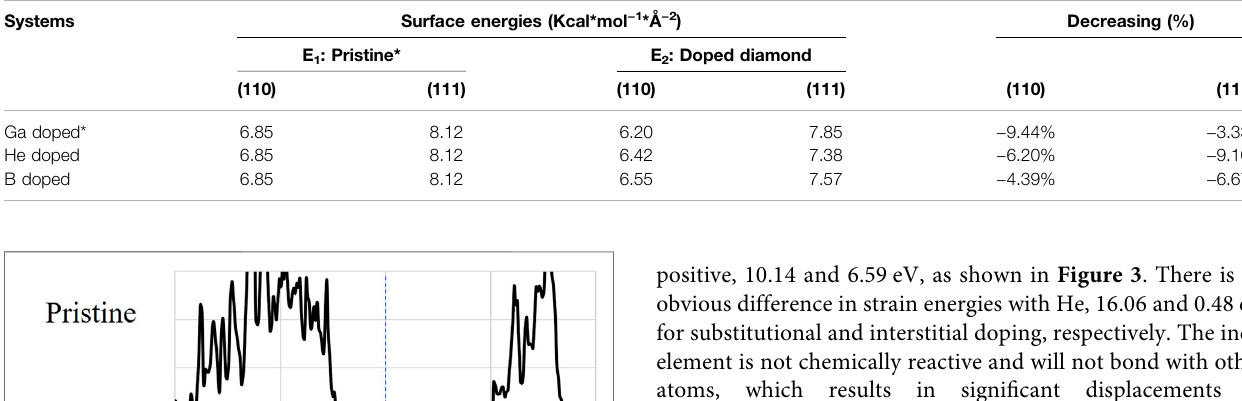
× 100%].{*labeledresultsbasedon E1